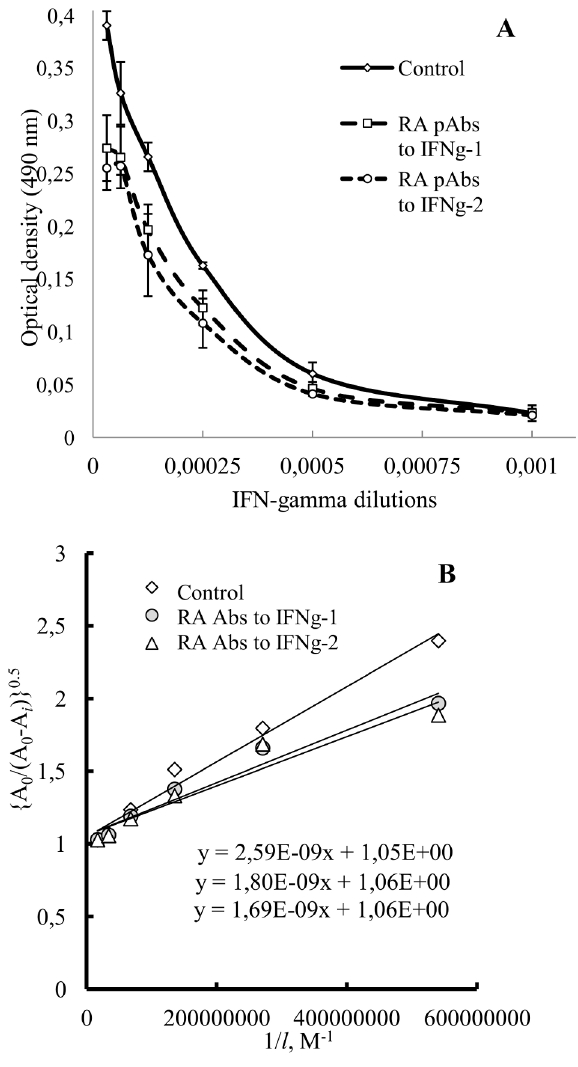
Figure 3. Effect of RA forms of anti-IFN-gamma antibodies on antigen (soluble form)-antibody interactions. The figure displays the effect of RA forms of Abs to IFN-gamma (RA Abs to IFNg) on the ability of soluble IFN-gamma to bind anti-IFN-gamma mAbs. The amount of mAbs which have not been bound by the respective antigen after reaching the dynamic equilibrium condition was measured by adding mAbs samples with different concentrations of antigen (shown on X axis of A where 0.00025 means dilution of starting interferon- gamma to 1:4000 times, 0.0005 means dilution of starting interferon- gamma to 1:2000 etc.) into antigen-coated wells of the assay plate for 45 min. (A): the influence of mAbs (1:50000 dilution) in the mixture with IFN-gamma in different concentrations in presence of RA forms of Abs to IFN-gamma or control after equilibration. The error bars represent the standard deviations of the measurements. The sample RA Abs to IFNg prepared by procedure 1 (RA Abs to IFNg -1) was mixed with mAbs initially. IFN-gamma in different concentrations was added 45 minutes later. RA Abs to IFNg prepared by procedure 2 (RA Abs to IFNg- 2) was mixed with IFN-gamma at different concentrations and mAbs was added 45 min later. It was shown that the order of reagent addition during pre-incubation is not important. RA samples are significantly different from control (p , 0.0001) for each RA sample. RA Abs to IFNg-1 and RA Abs to IFNg-2 do not differ significantly from each other (p=0.2). (B): there are linear relationships from 1/ l i calculated from ‘‘ A ’’ curves and the equations for these linear functions where the slopes are equal to the dissociation constants for antigen- antibody